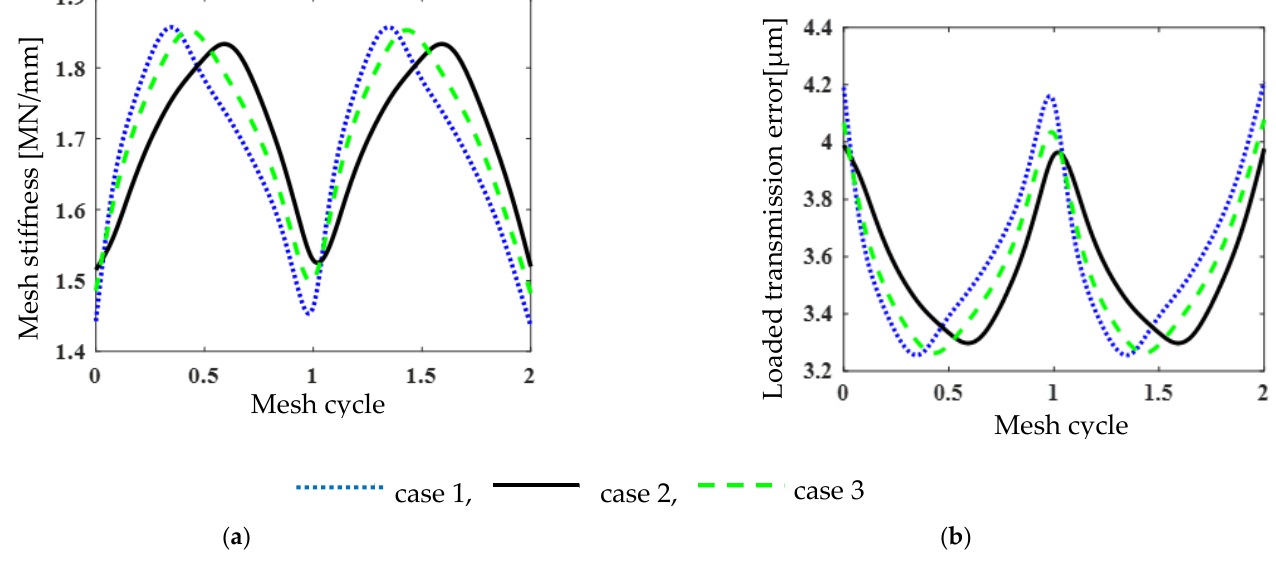
Figure 3. Mesh stiffness ( a ) and loaded transmission error ( b ) of the pinion.